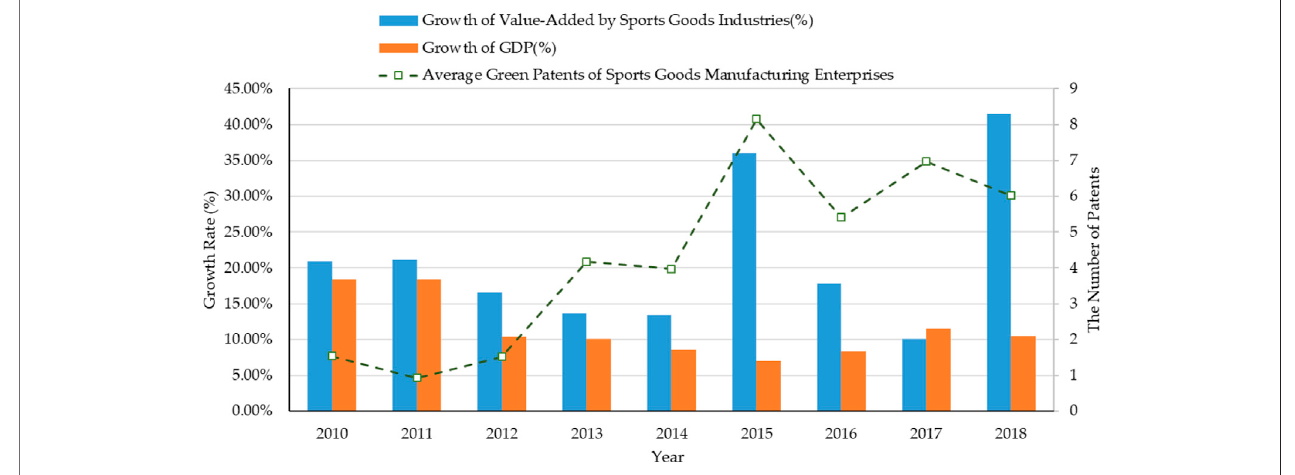
FIGURE 2 | Sports goods industries in